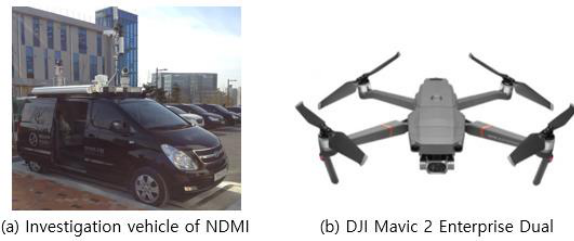
Figure 1. Disaster investigation platforms in this